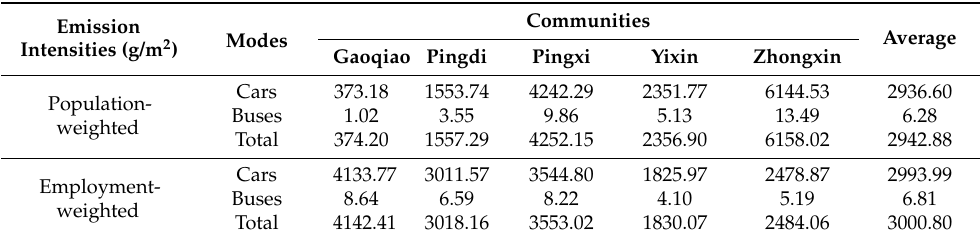
Table 8. Population- and employment-weighted emission